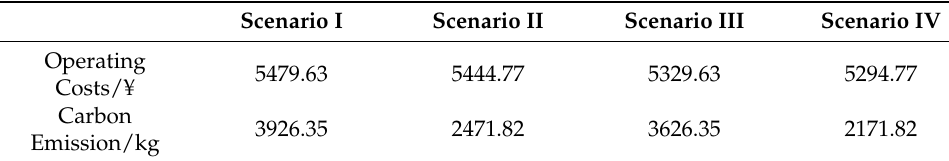
Table 3. Analysis of the low-carbon characteristics of